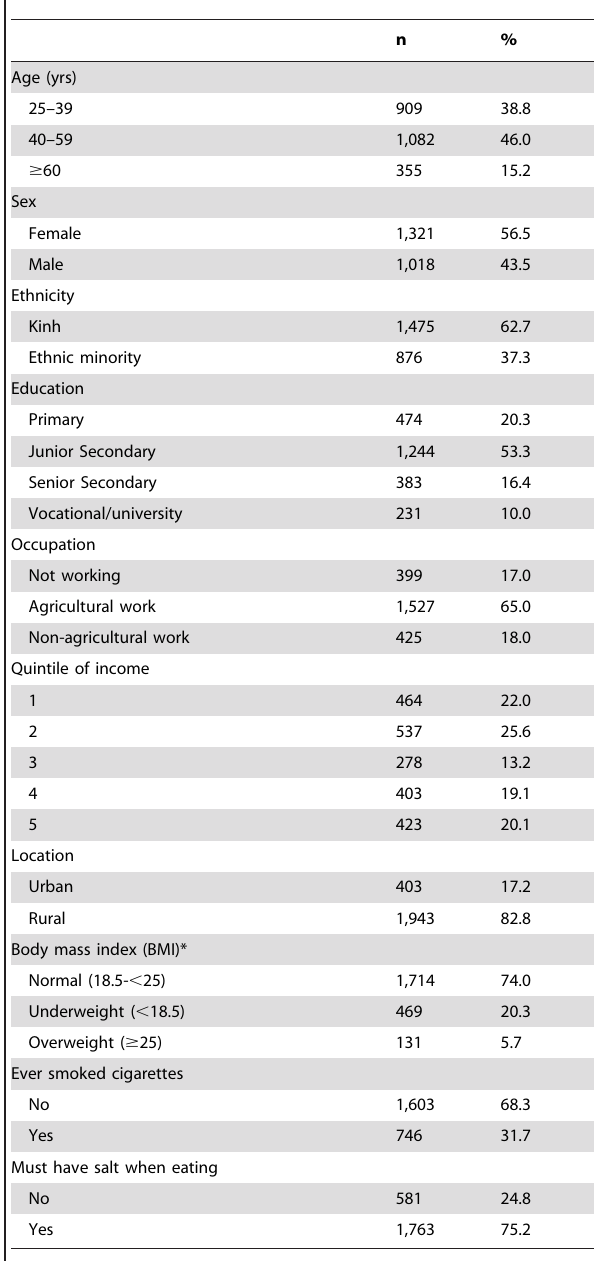
Table 1. Study Population